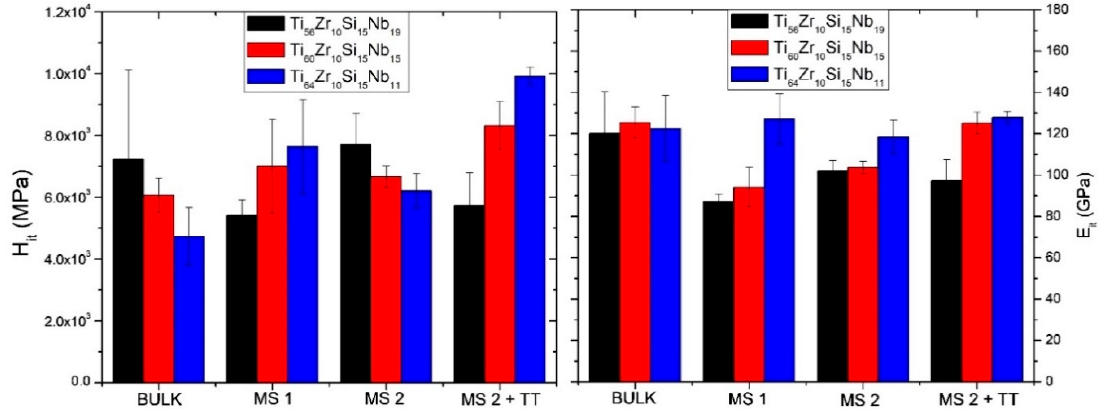
Figure 10. Hardness and Young’s modulus as a function of processing parameters.